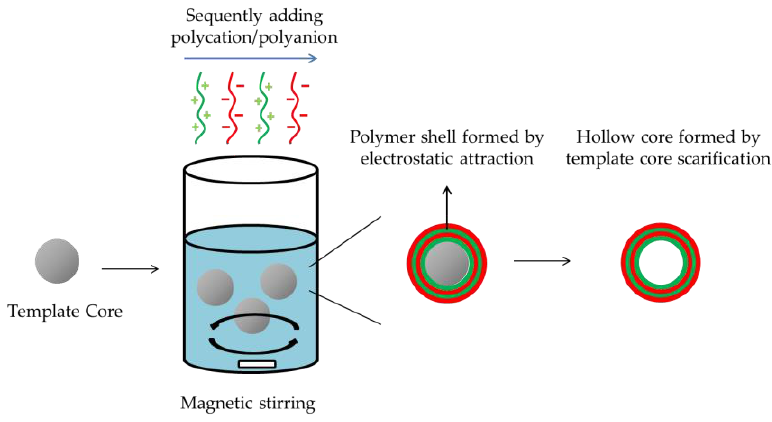
Figure 3. Schematic representation of nanocapsule formulation by LBL method.